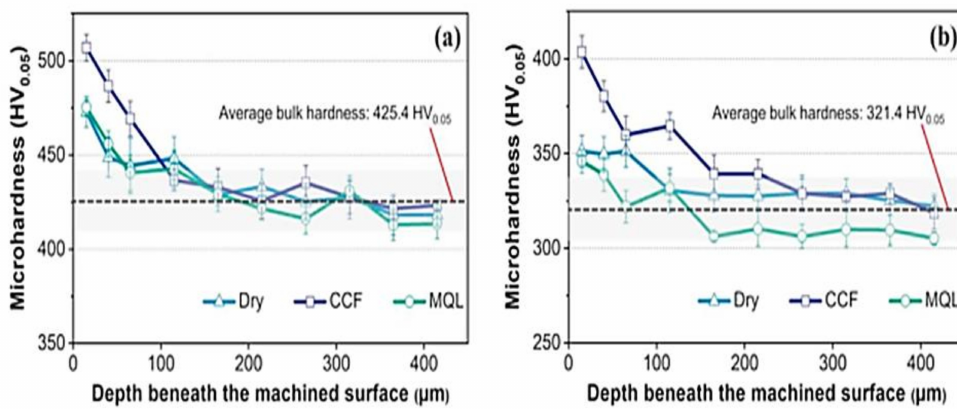
Figure 43. The microhardness below the workpiece surface for ( a ) austempered ductile iron and ( b ) cast steel samples